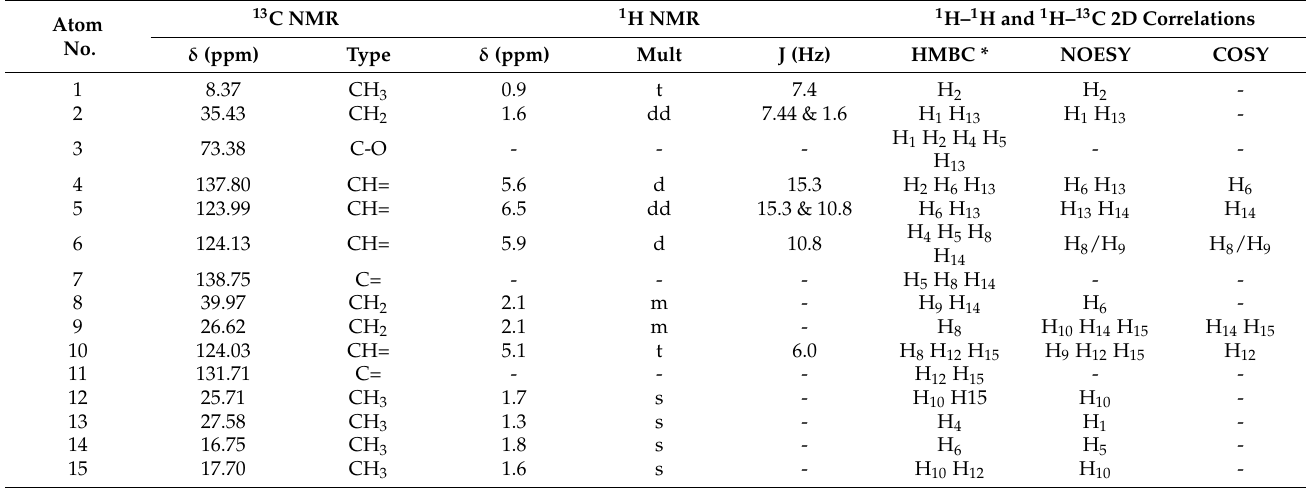
Table 2. Full NMR data of 1,2-dihydro-4,5-dehydronerolidol ( 58 ) (500 MHz, 300 K and CDCl 3 ).